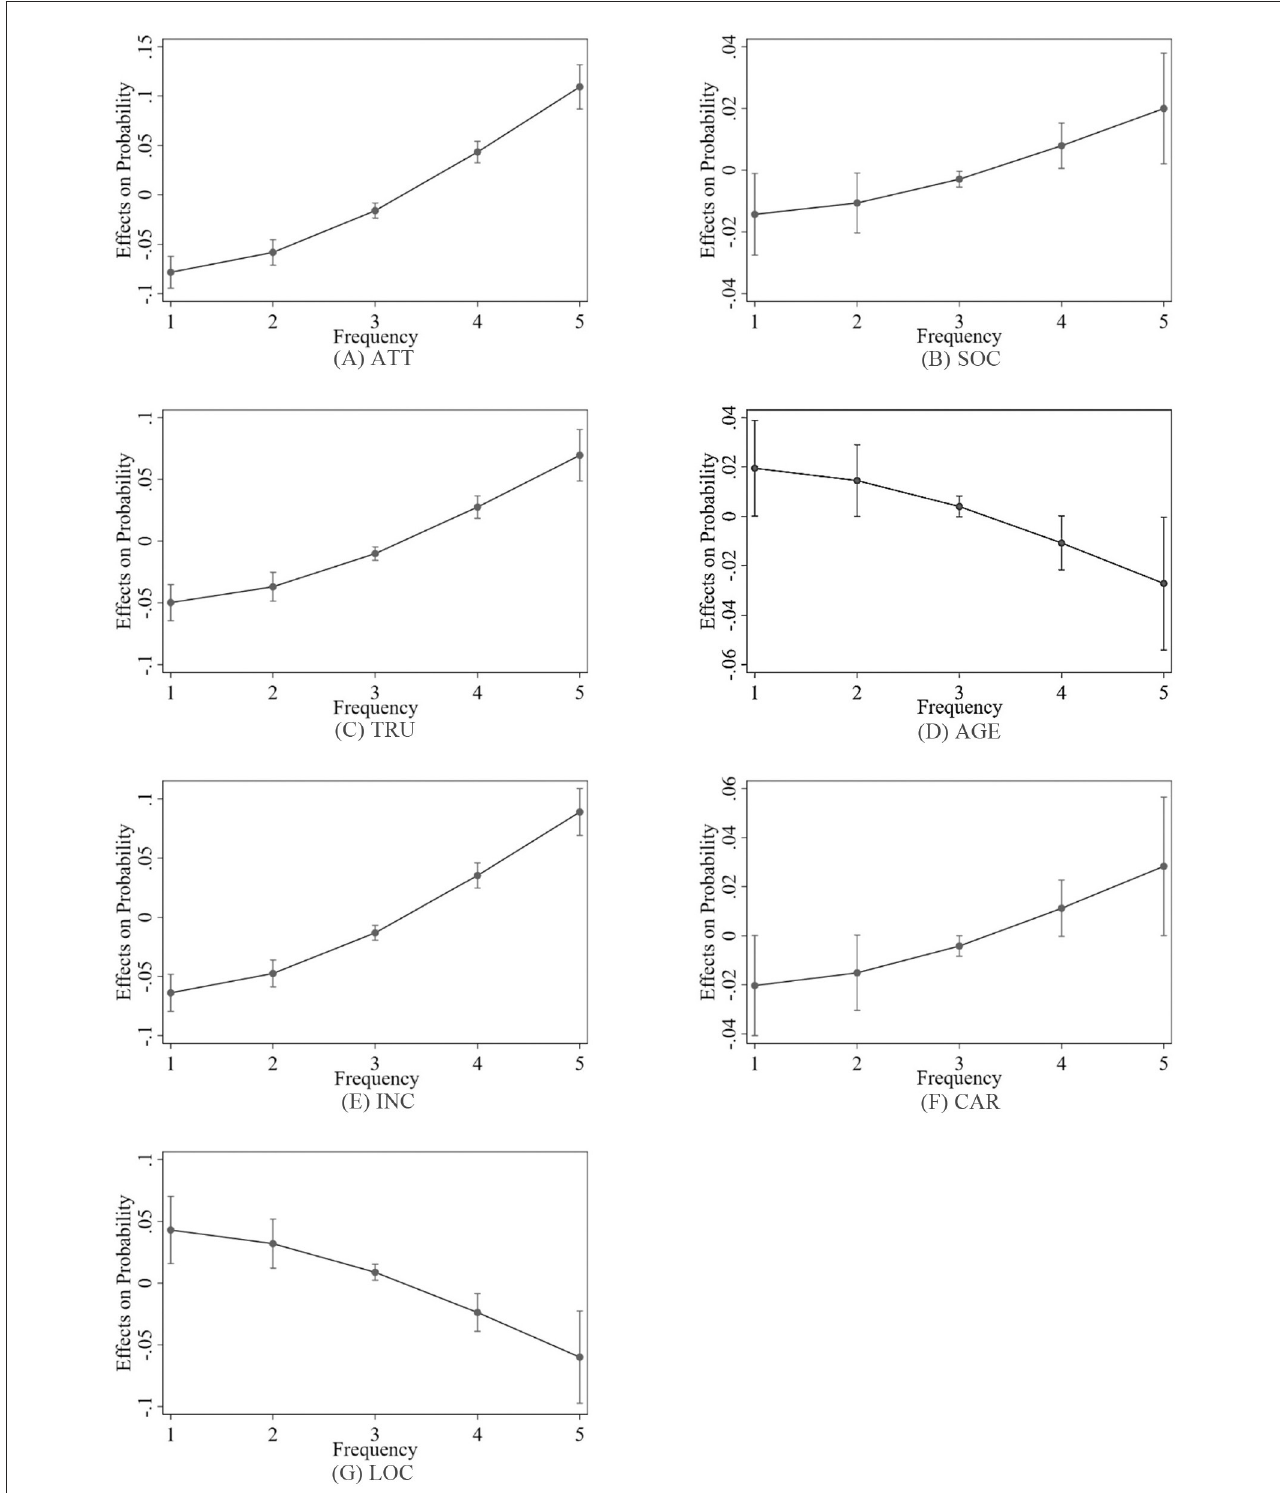
FIGURE4 Average marginal effects at 95% confidence intervals after the